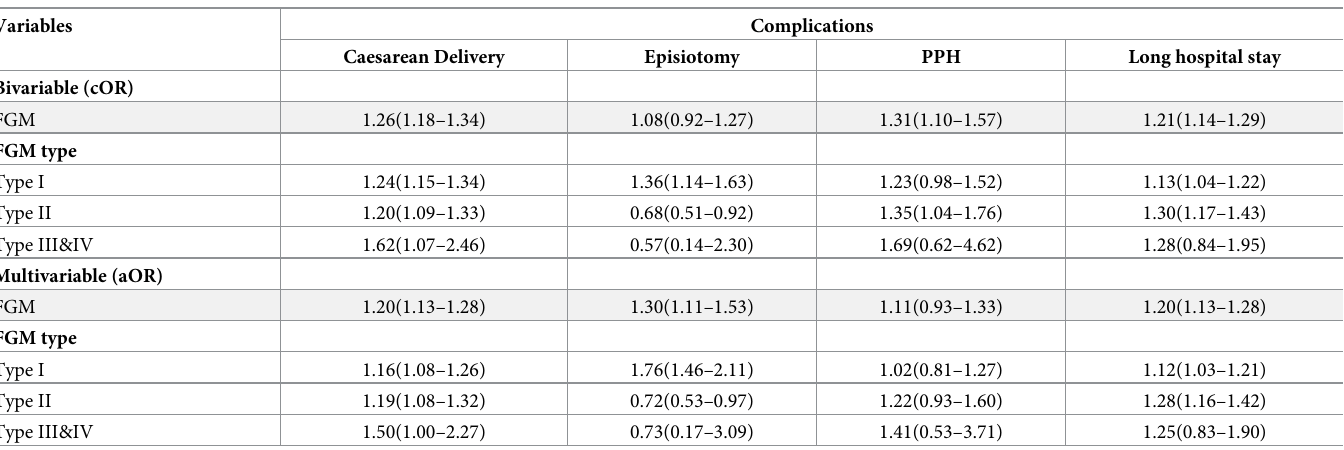
Table 3. Maternal adverse outcomes associated with FGM (N = 30286).